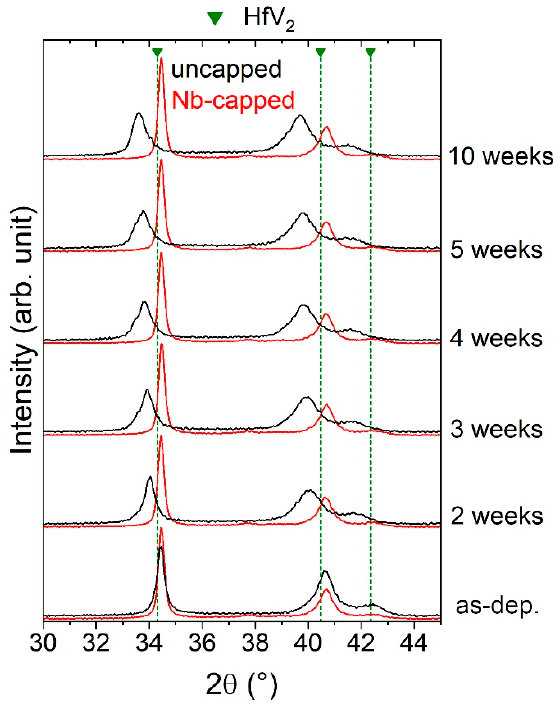
Figure 3. X-ray di ff ractograms of uncapped HfV 2 (black) and Nb-capped HfV 2 (red) for varying storage Figure 3. X-ray diffractograms of uncapped HfV 2 (black) and Nb-capped HfV 2 (red) for varying times in storage times in air.